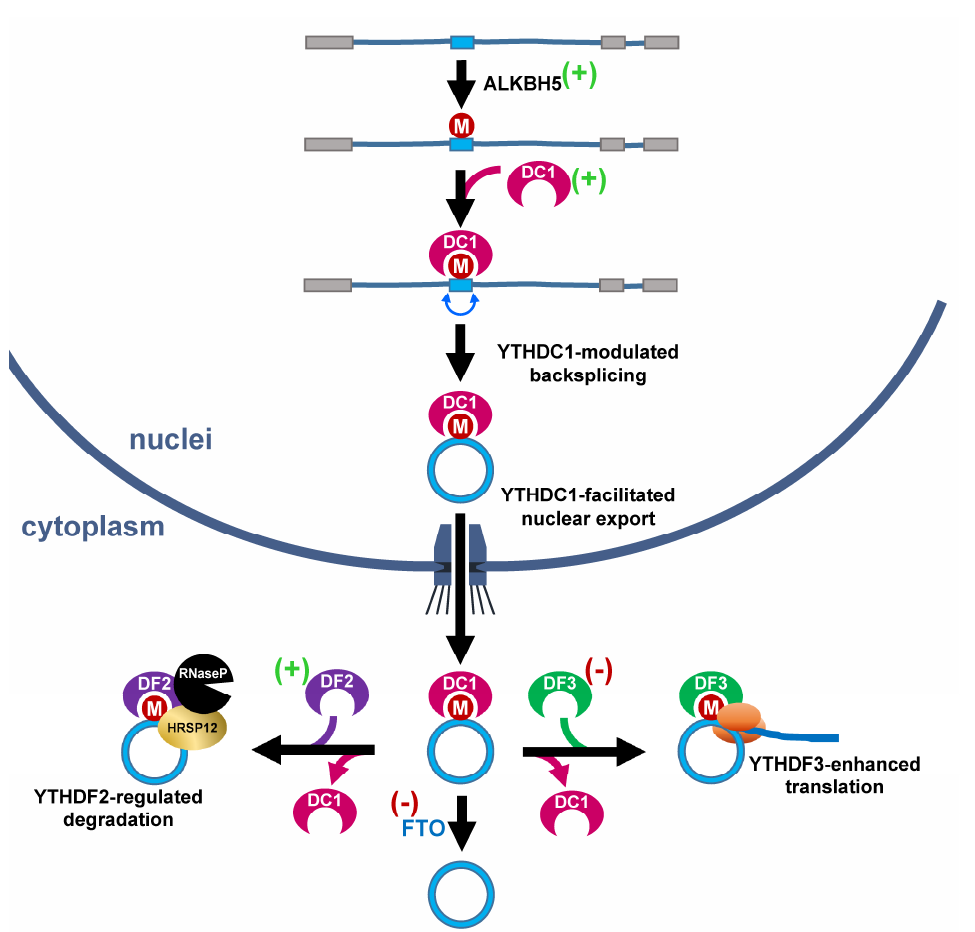
Figure 4. Potential roles of hypoxia-responsive m6A effectors in regulation of circRNA functions. The deposition of m6A on exons by m6A writers (such as ALKBH5) allows the binding of YTHDC1 (DC1), which promotes the backsplicing of circZNF609. In addition, YTHDC1 also helps the nuclear export of circRNA. In cytoplasm, the m6A-harboring circRNA is recognized by YTHDF3 (DF3) and proceeded to translation, or alternatively bound by YTHDF2 (DF2) and targeted for degradation. The m6A eraser, FTO, eventually removes the modification. (+): reported to be upregulated by hy- poxic stress; (−): suppressed by hypoxia.